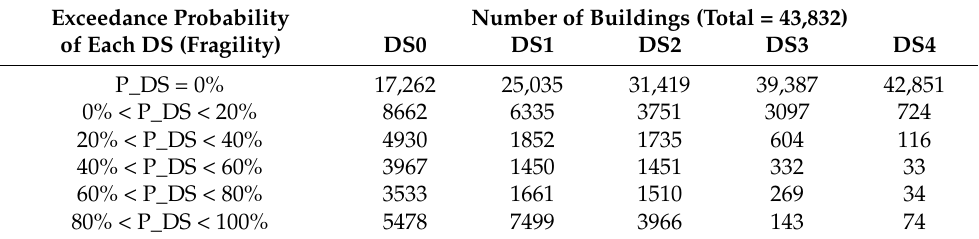
Table 5. Damage states exceedance probability corresponding to each flood-induced hazard for the exposed buildings within the County of Santa